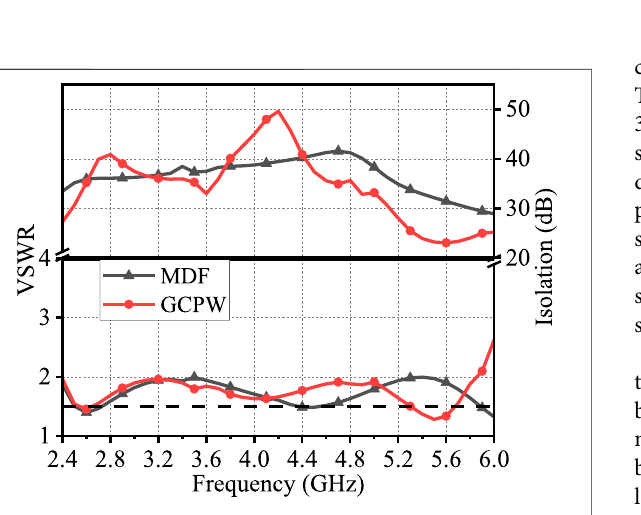
FIGURE 3 | Simulation results of two